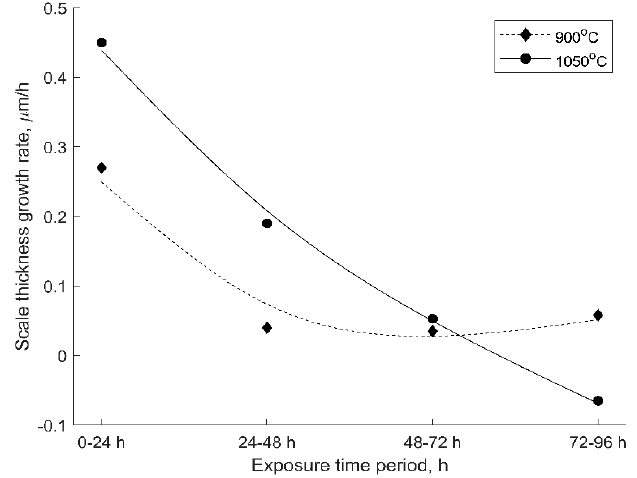
Figure 11. The oxide scale thickness growth rate as a function of the exposure time period.